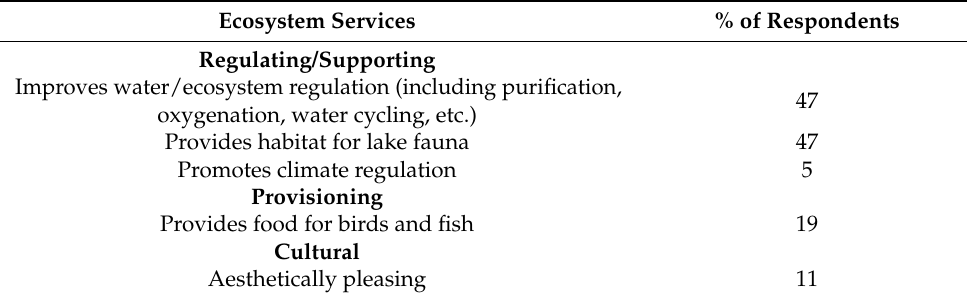
Table 2. Perceived benefits of aquatic plants categorized into various ecosystem service benefits (categorized based on TEEB, 2010 [32]). Note that percentages add up to more than 100 as many respondents mentioned more than one benefit. Only the responses from the semi-structured ques- tionnaires were included in